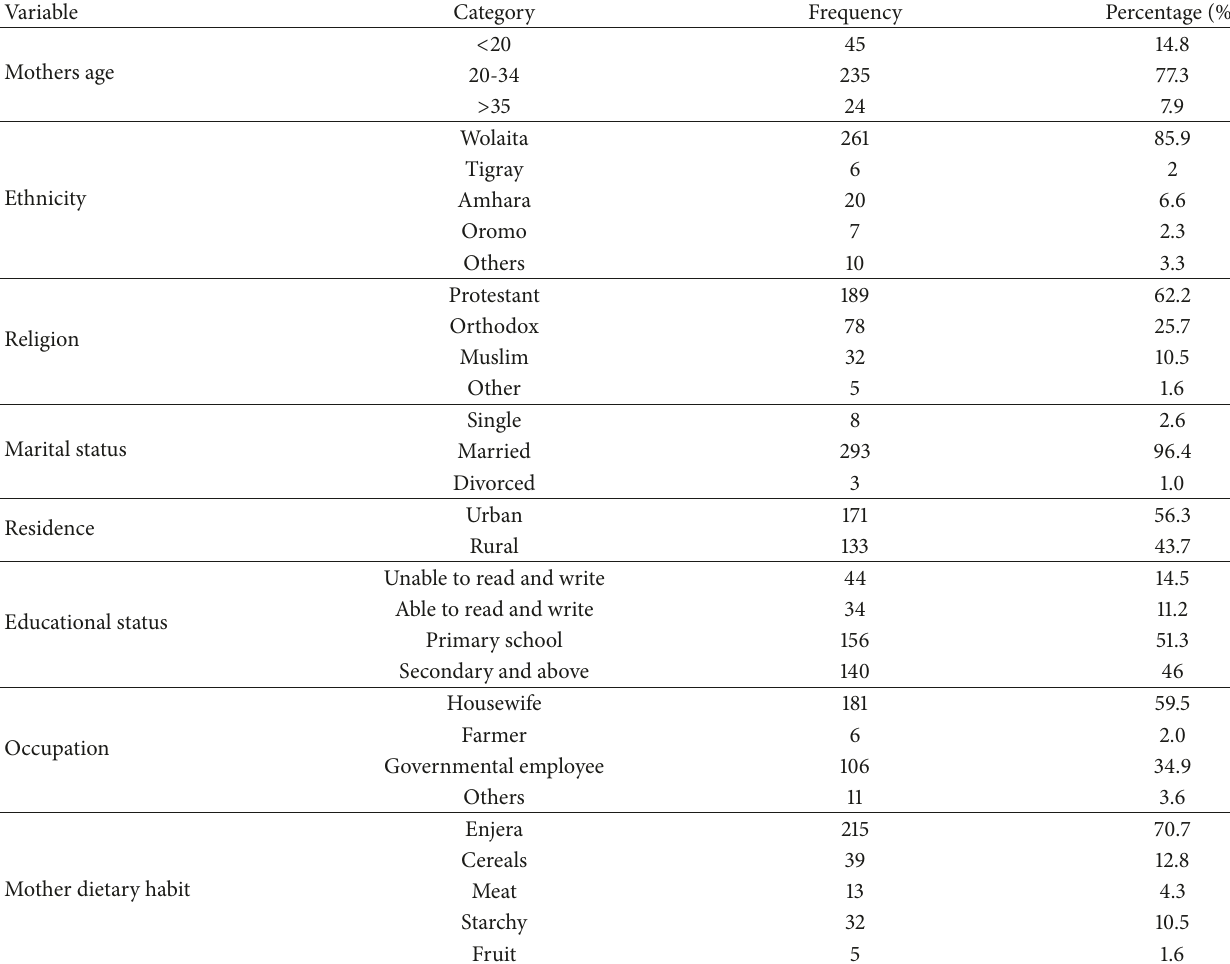
Table 1: The socio-demographic characteristic distribution of mothers with their neonate at Wolaita Sodo University teaching and referral hospital,